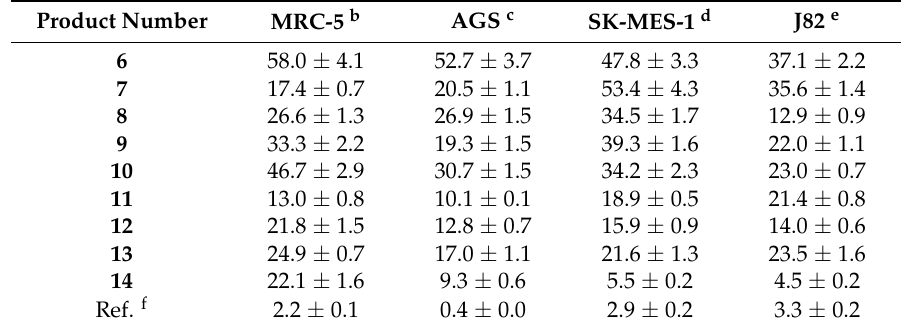
Table 3. IC 50 values of acylnaphthoquinone α -aminoesters conjugates 6 – 14 . IC 50 ± SEM ( µ M) a